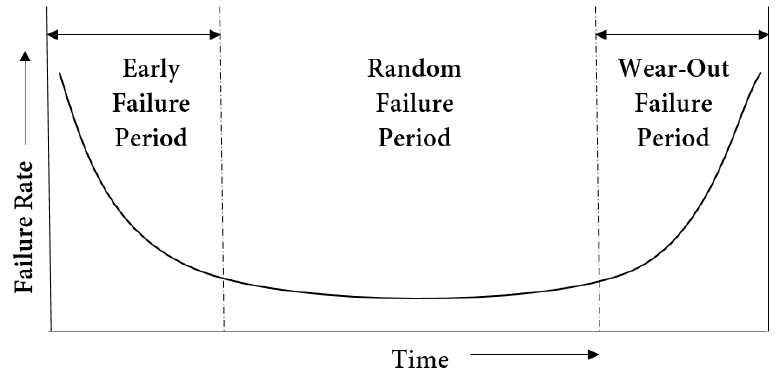
Figure 1. A descriptive analysis of an aluminium electrolytic capacitor failure